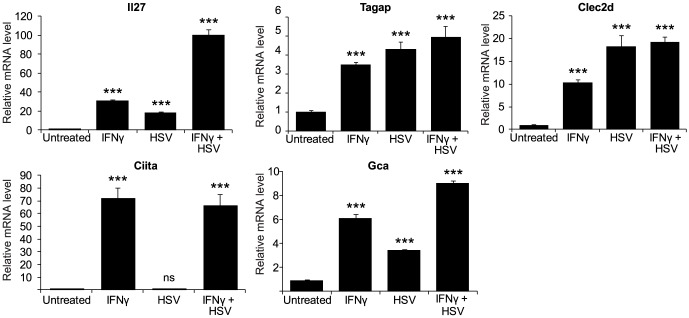
Induction of candidate gene expression by IFN-γ and HSV-GFP infection.Cells were seeded and either left untreated or treated with IFN-γ (10 ng/ml) for 16 h. HSV-GFP (MOI = 0.5) was used to infect the cells as indicated above. qRT-PCR was performed to measure the relative expression of all candidate genes relative to the untreated control. Gapdh was used as internal control for normalization. Data shown are results from 3 independent experiments. ***P<0.001 compared to untreated control by one-way ANOVA with Dunnett's post-test.